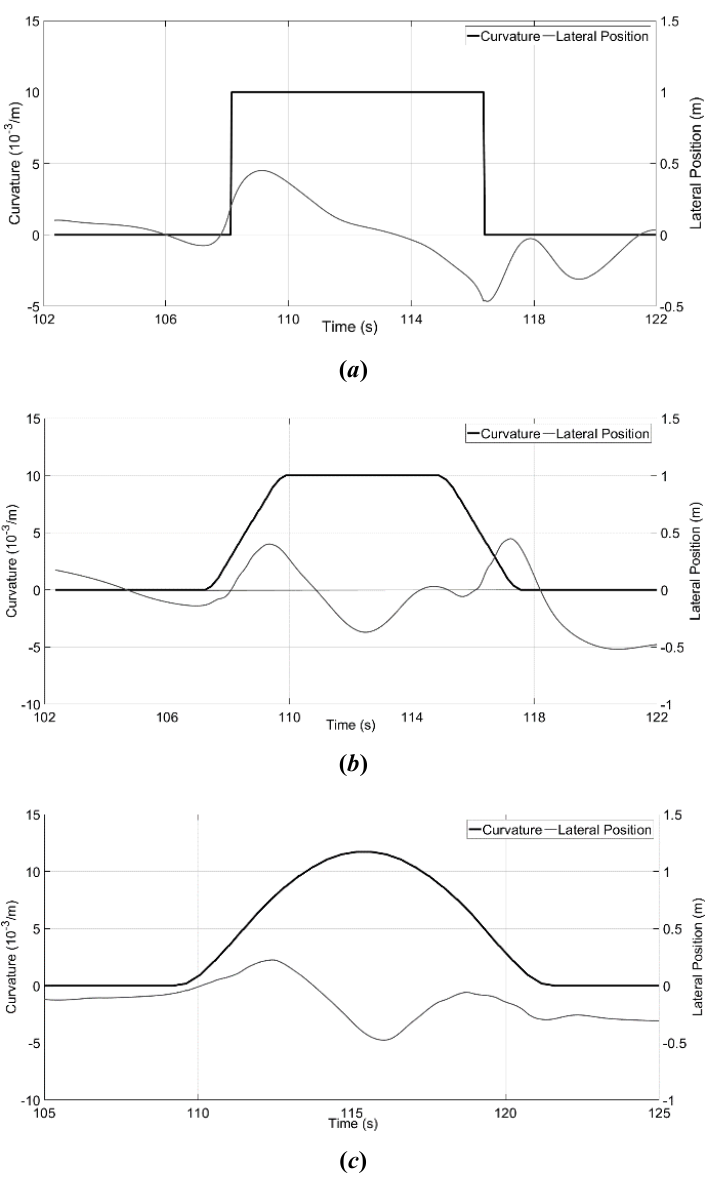
Figure 4 Example trajectories as driven by a participant on the dif- ferent curves: ( a ) circular, ( b ) clo- thoid, ( c ) continuous